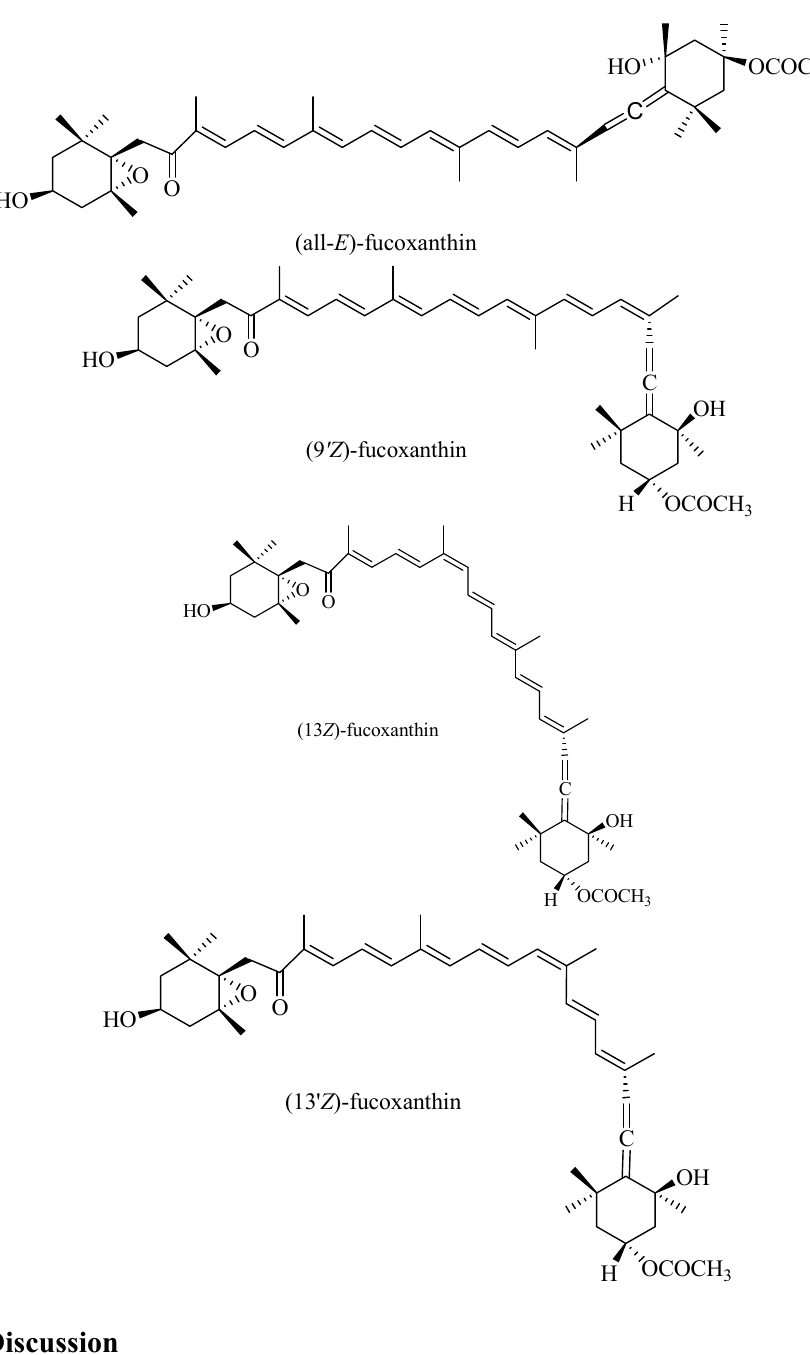
Figure 1. Structures of Fuco